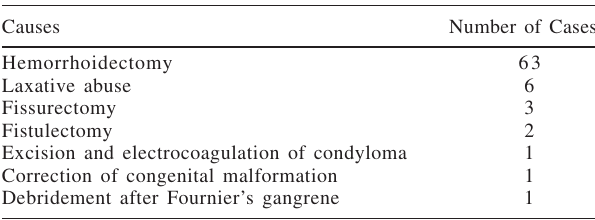
Figure 1 - Sarner´s anoplasty. After dissection of a rectangular cutaneous flap, its distal border is incised and the proximal border is sutured to the fibrotic tissue resection line.